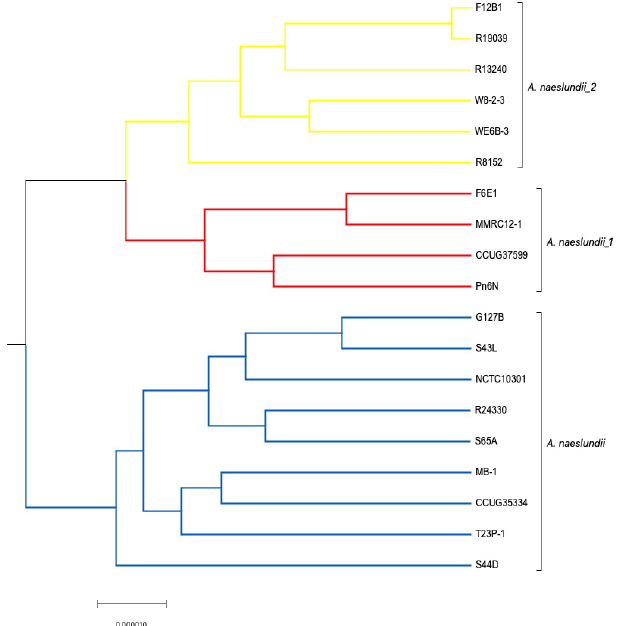
Figure 3. ClonalFrame analysis of A. naeslundii isolates using whole genomes. * Three independent groups were observed, known as A. naeslundii , A. naeslundii_1, and A.